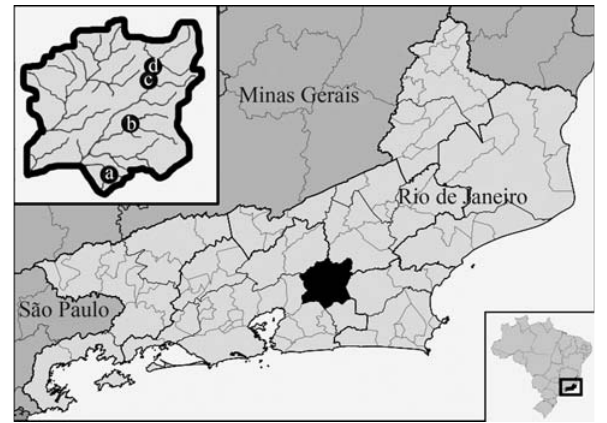
Figure 1 - Map showing four different sites along the Guapimirim river basin, in the State of Rio de Janeiro, Brazil. In the large box, the area of Cachoeiras de Macacu county indicating sampling sites: (a) Ypiranga community; (b) Santana de Japuíba county; (c) Macacu river and (d) the town of Cachoeiras de Macacu.